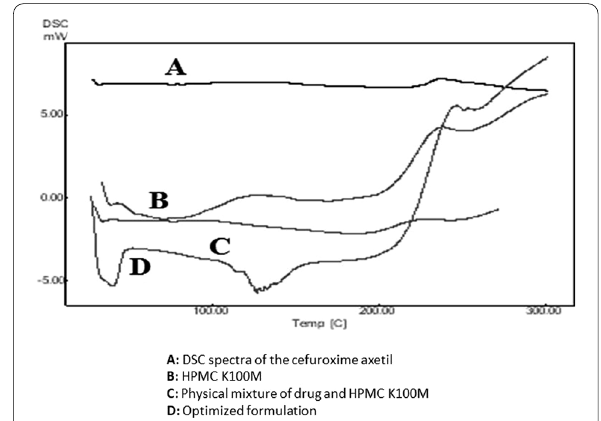
Fig. 5 DSC spectra of the cefuroxime axetil ( A ), HPMC K100M ( B ), physical mixture of drug and HPMC K100M ( C ) and optimized formulation ( D